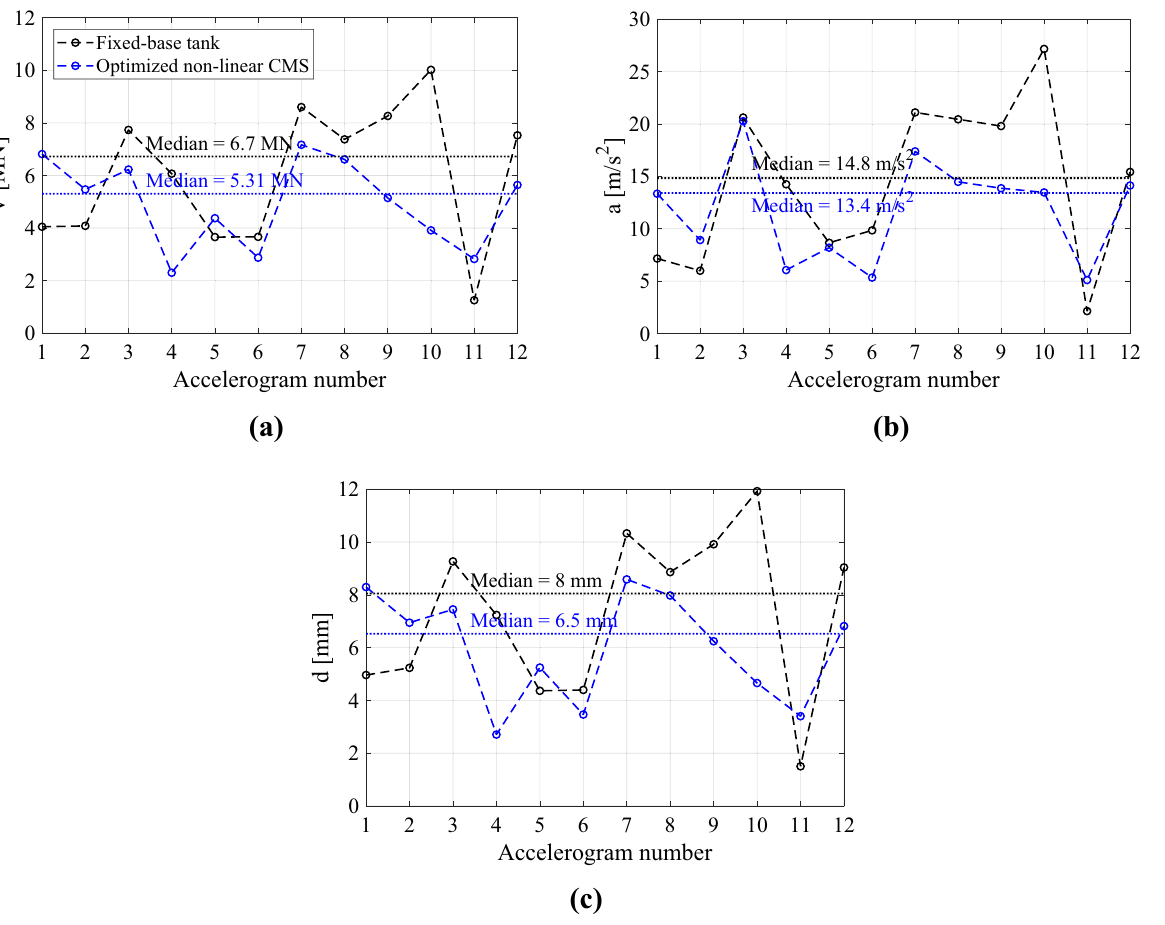
Figure 10. Maximum and median values of the ( a ) base shear, ( b ) absolute acceleration and ( c ) interstorey drift of the optimized nonlinear CMS w.r.t. the fixed-base tank for each accelerogram listed in Table 2.